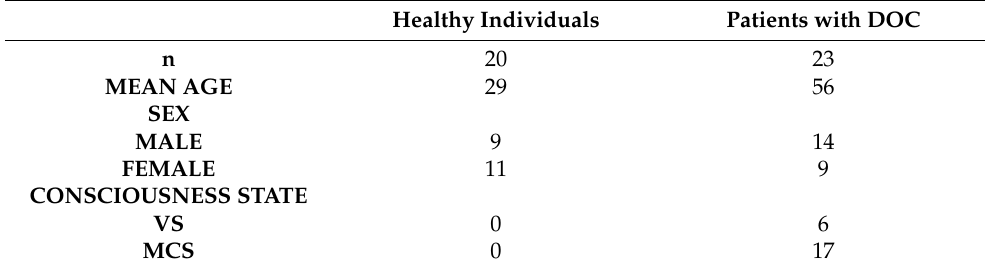
Table 3. Study Sample